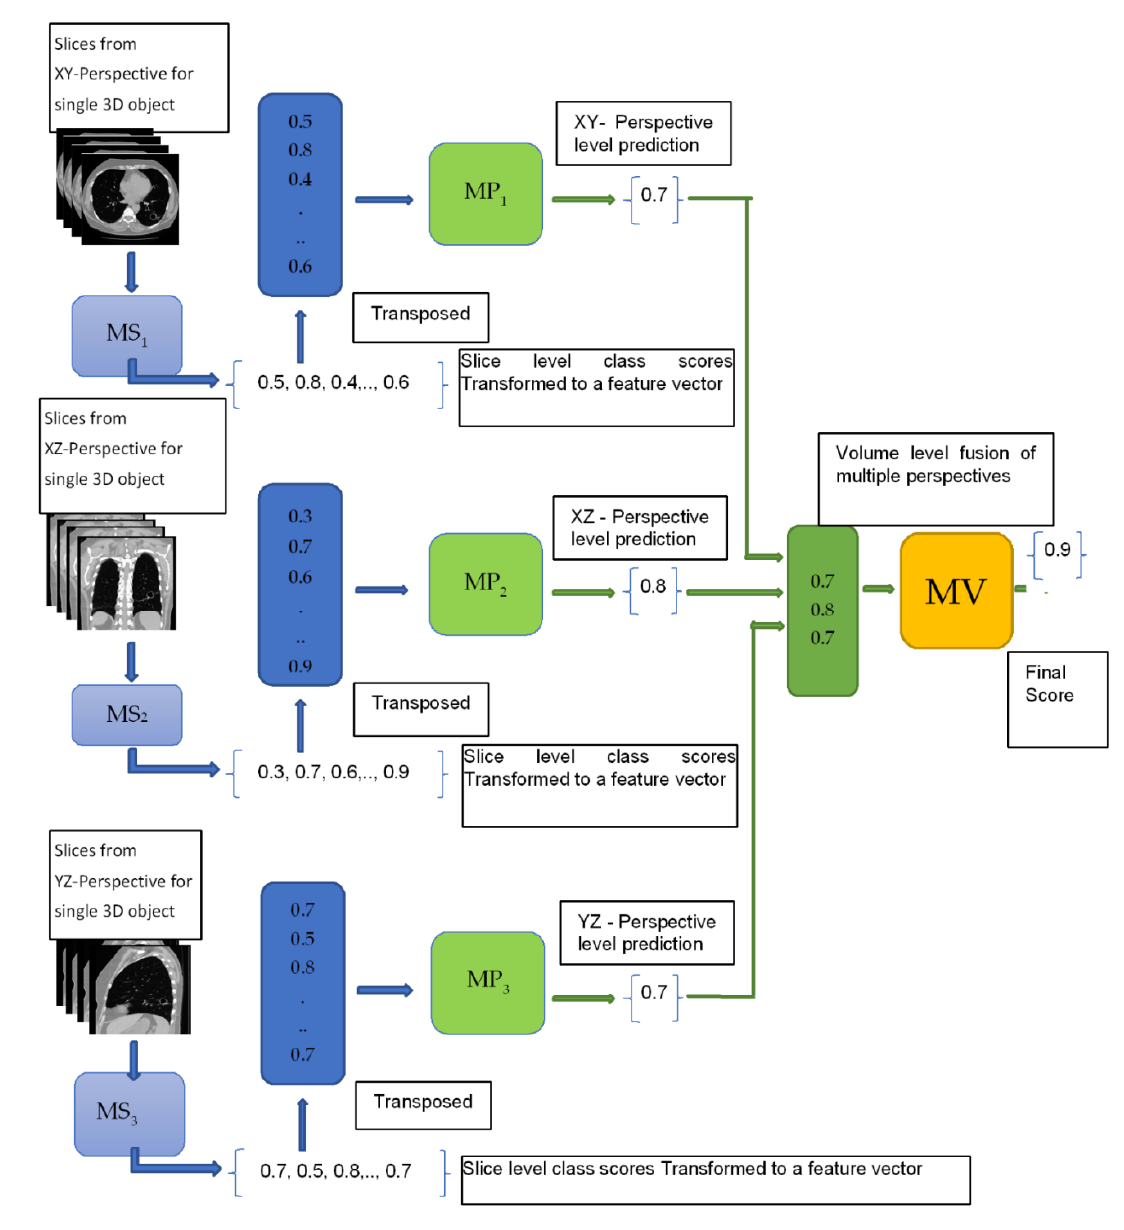
Figure 4. Re-arraignment of the class scores from slice level classification to create an input feature for the perspective module.